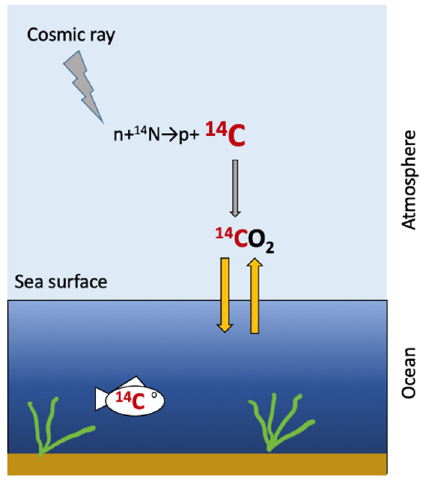
Figure 1. Schematic representation of the mechanism underlying the uptake of carbon from ma- rine organisms.